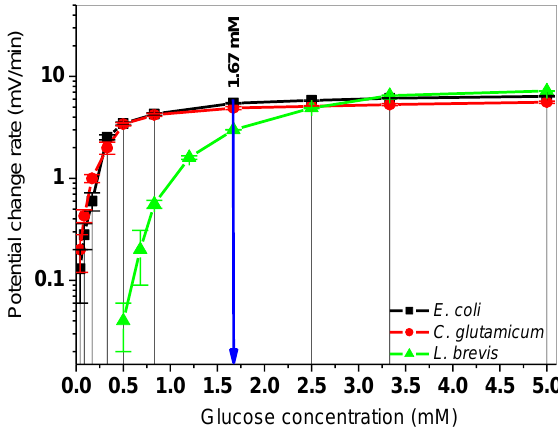
Figure 4. Correlations between the LAPS signal response and the glucose concentration. Mean values and standard deviations of PCR values of E. coli (black), C. glutamicum (red), and L. brevis (green) are depicted for different glucose concentrations (0.042, 0.085, 0.17, 0.20, 0.33, 0.40, 0.50, 0.68, 0.83, 1.20, 1.67, 2.50, 3.33, and 5 mM) at a constant cell number of 4.8 × 10 9 cells. Three independent measurements were performed within the first 6 min after adding cells to calculate the mean PCR values. The blue arrow in the diagram indicates a particular glucose concentration (1.67 mM), which was exemplarily chosen to compare calibration curves of metabolic responses of the three microorganisms by cell number variations, see also Figure 5.